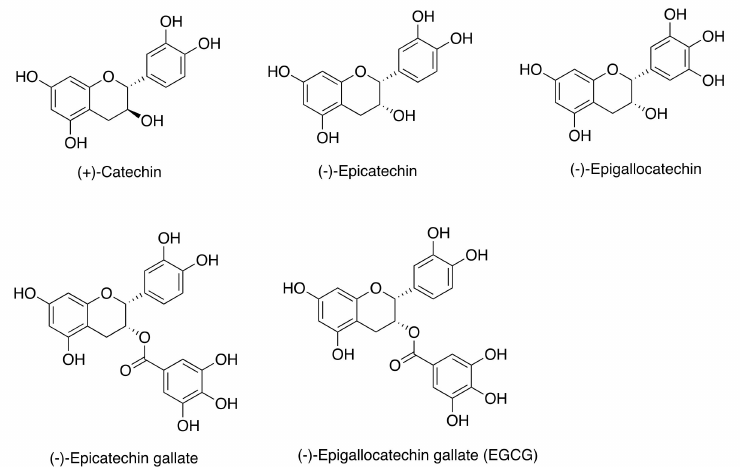
Figure 7. Chemical structures of (+)-Catechin and four major green tea catechins: (-)-Epicatechin, (-)-Epigallocatechin, (-)-Epicatechin gallate, and (-)-Epigallocatechin gallate